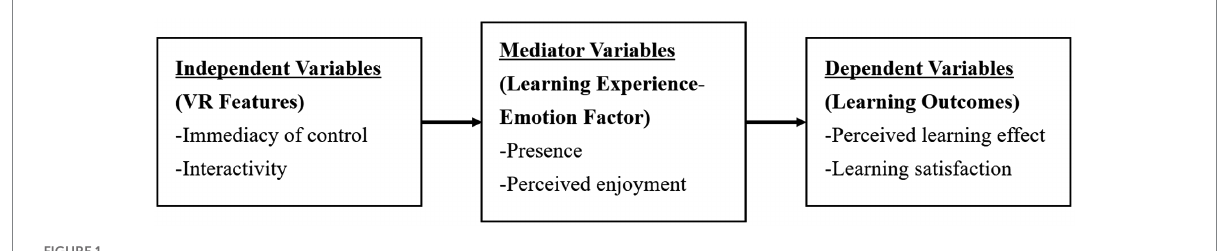
FIGURE 1 Conceptual framework of the outcomes and their causal relationships in an interactive virtual reality (IVR)-based learning